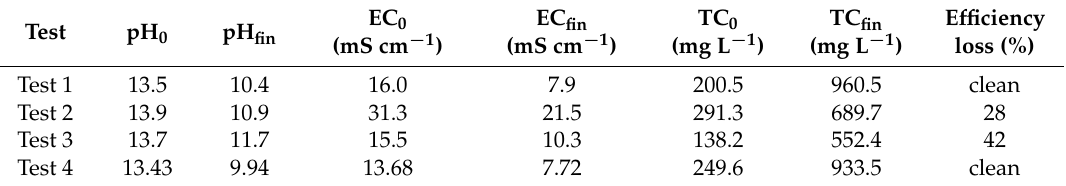
Table A1. Selection of four consecutive CO 2 capture tests, performed with membrane contactors. Tests 1 and 4 are representative of clean membranes condition (cleaning routine performed after Test 3).